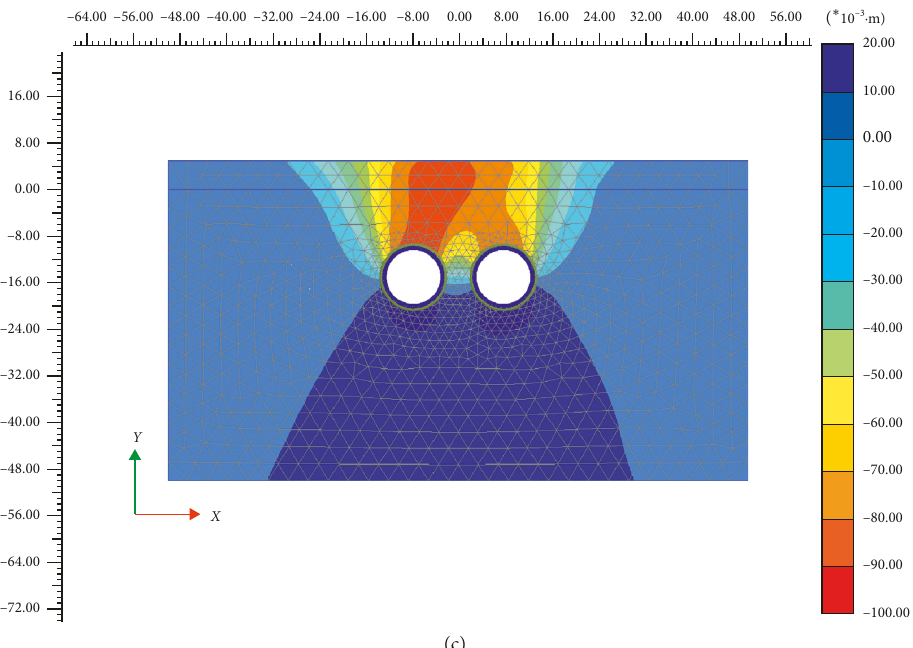
Figure 5: (a) Twin tunnels ( u 0.55 D ) in horizontal configuration (dimensions in cm). (b) Settlement trough of horizontal twin tunnels. (cid:31) (c) Displacement contours of horizontal twin tunnels ( u 0.55 D (cid:31)